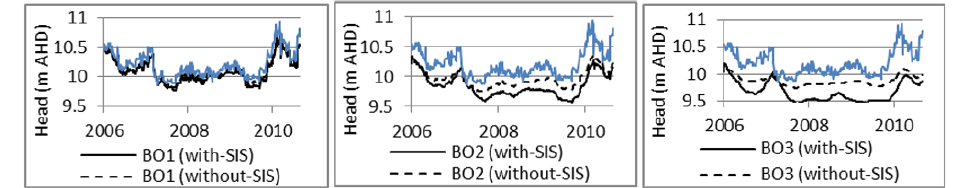
Fig. 11. Groundwater head dynamics at the observation wells on transect B1 for the with-SIS and the without-SIS scenarios.